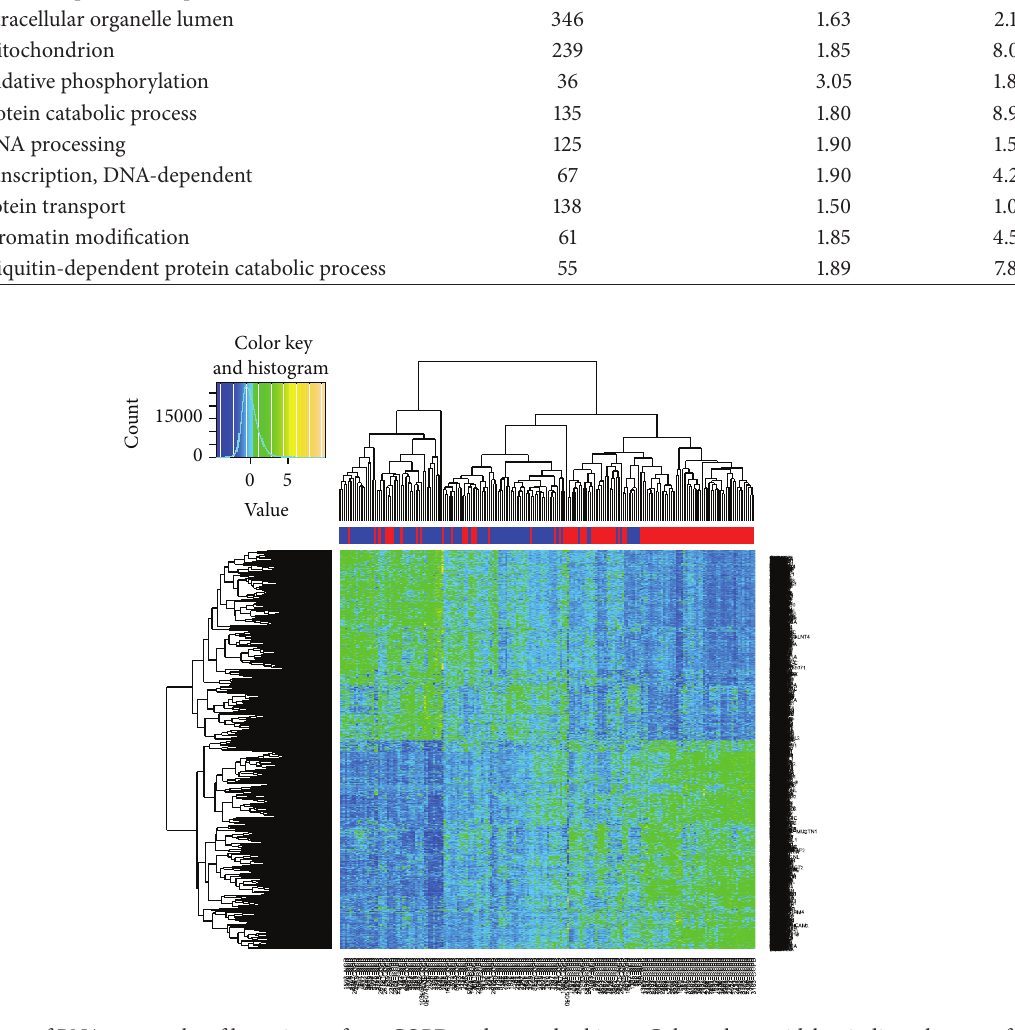
Figure 4: Heat map of RNA-seq results of lung tissues from COPD and control subjects. Color column sidebar indicated status of subjects, where red means COPD subjects and blue means control